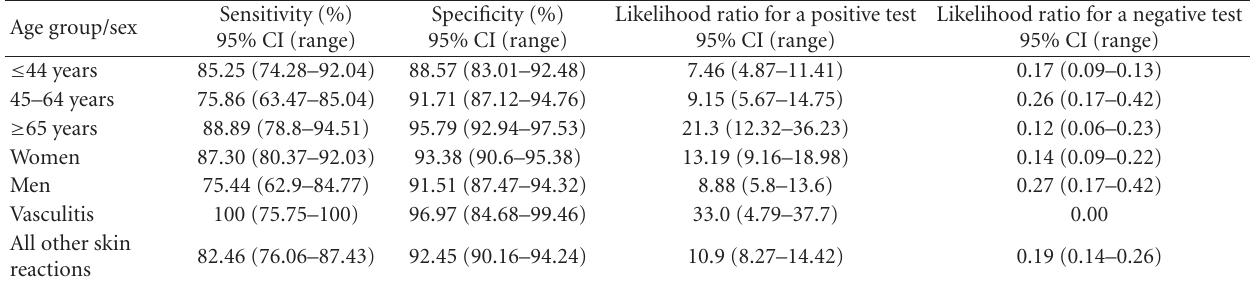
Table 6: Sensitivity and specificity of the IFN-gamma release test, and positive and negative likelihood ratio according to patient’s age groups, sex, and type of